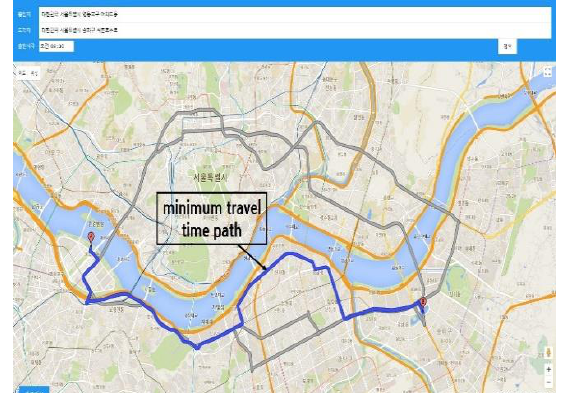
Figure 4. Comparison of similarity according to